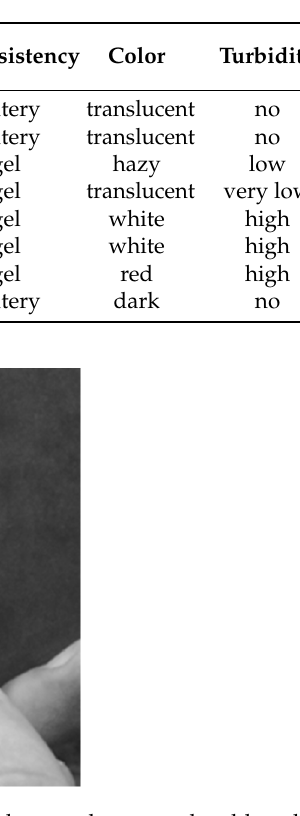
Table 1. Experimental conditions of the tests performed to optimize the extraction method from endosperm crude ivory nut parenchyma, together with the physical characteristics of the resulting samples. Particle size (D h ) and polydispersity index (PDI) were measured after ultrasonication of the samples.